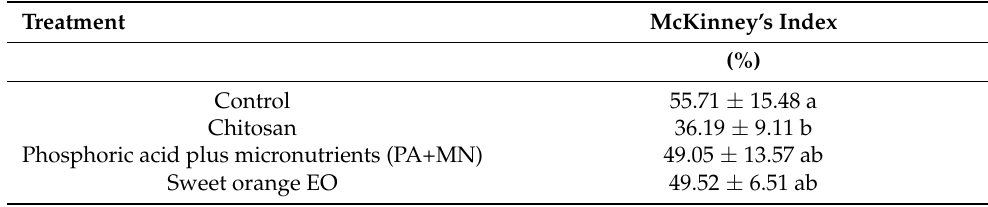
Table 1. McKinney index of gray mold recorded on strawberries treated with commercial natural compound formulations. The fruit were kept for 7 d at 4 ± 1 ◦ C, followed by 5 d shelf life at 20 ◦ C and 95–98% RH. Different letters indicate that the values are significantly different according to a Tukey’s test ( p ≤